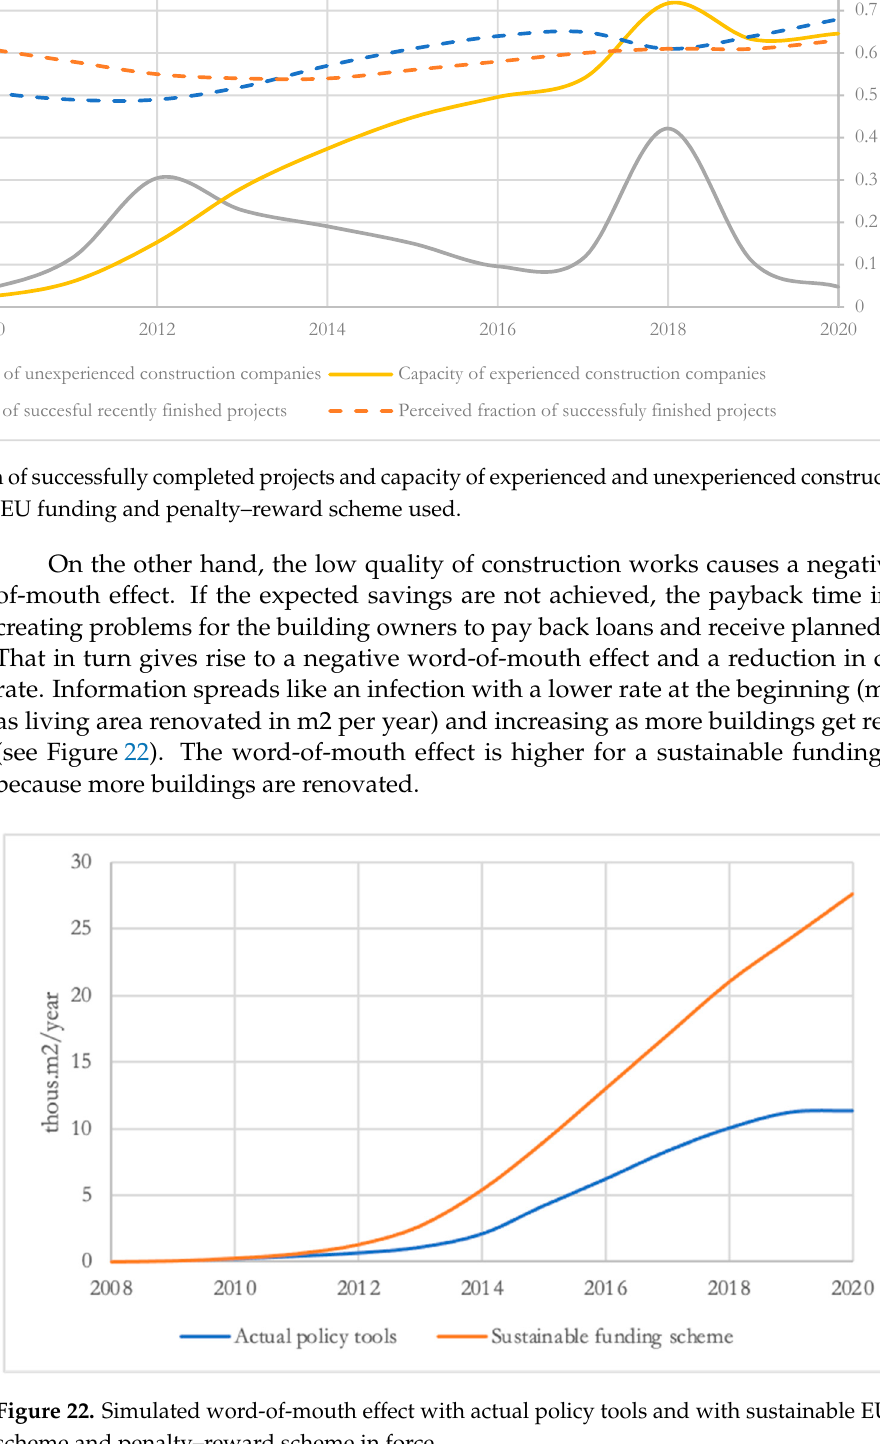
Figure 20. Simulated fraction of successfully completed projects and capacity of experienced and inexperienced construc- tion companies with existing policy tools applied.